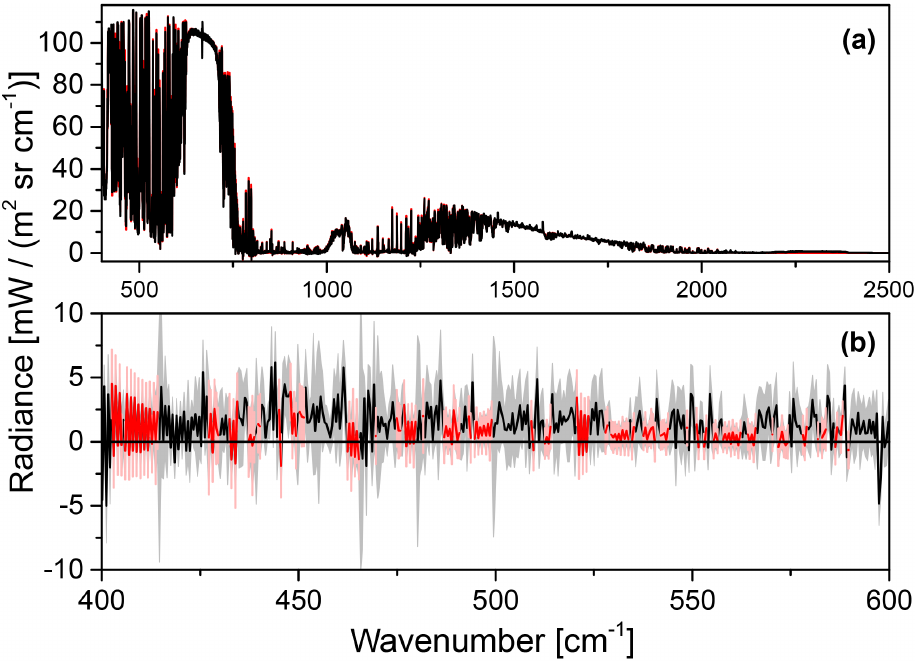
Figure 10. (a) Comparison of a measured ER-AERI spectrum (black) recorded on 13 December 2013, 08:28UTC, and the corresponding synthetic LBLRTM spectrum (red). (b) Mean spectral residuals (synthetic minus measured radiances) derived from the continuum retrieval data set (black) and residual uncertainty (grey). Spectral windows used for continuum retrieval are highlighted in